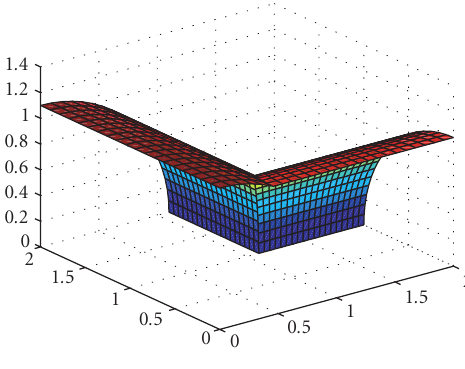
Figure 3.1. Two cylindrical